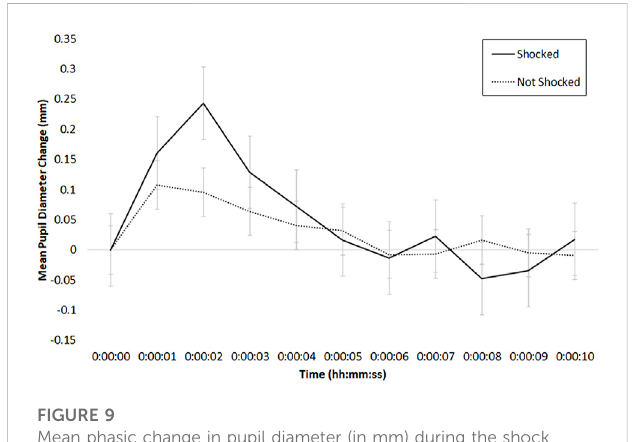
FIGURE 9 Mean phasic change in pupil diameter (in mm) during the shock session, time-locked to the onset of a shock (solid line) or no shock (dotted line) event; bars indicate standard error of the